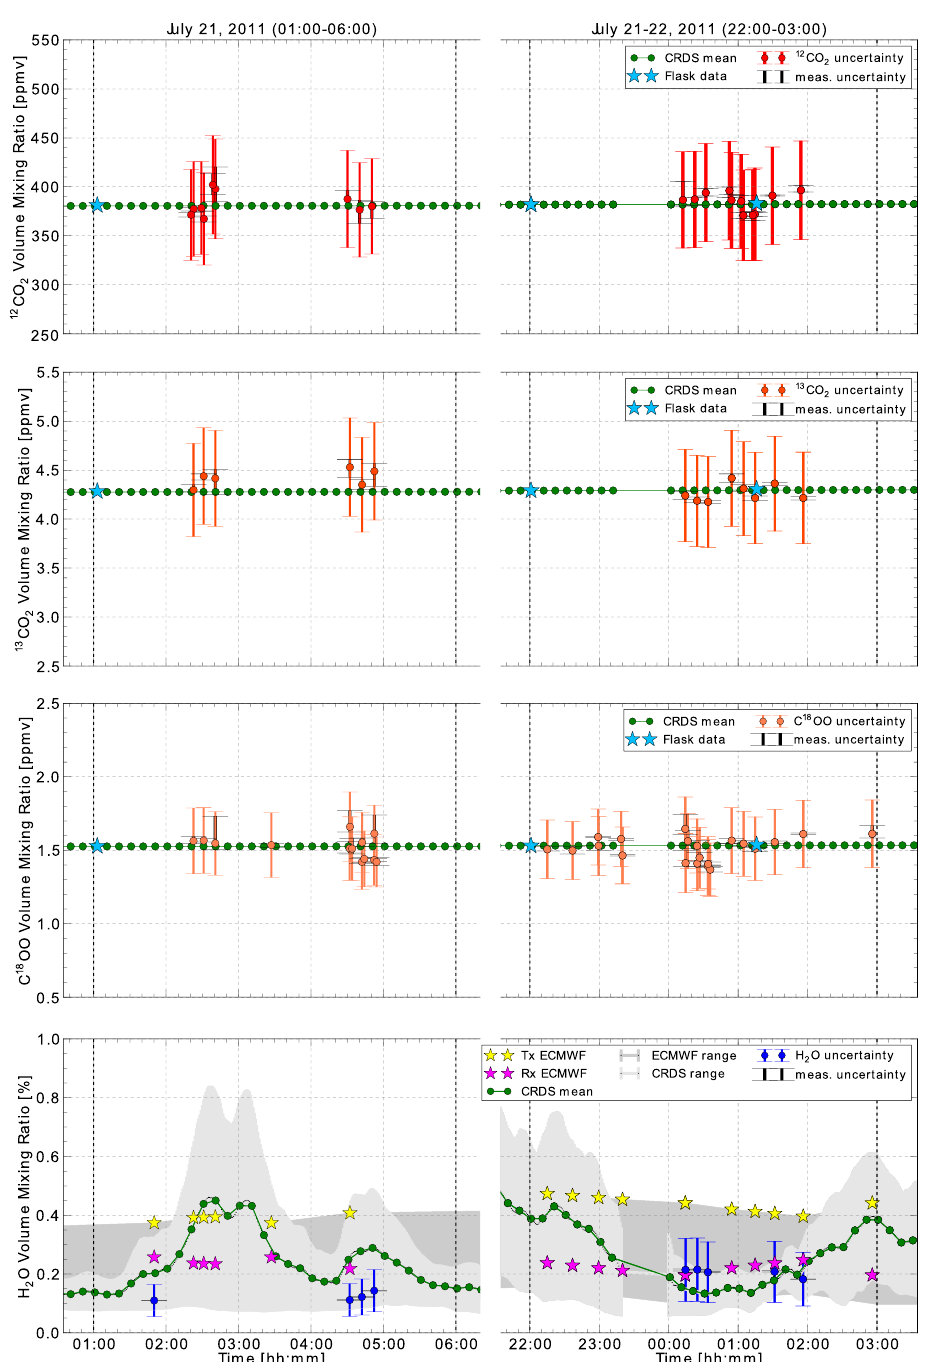
Figure 8. Retrieval results for 12 CO 2 (top panel), 13 CO 2 (upper-middle panel), C 18 OO (lower-middle panel), and H 2 O (bottom panel) volume mixing ratios for the ∼ 10min periods of all available species data from the two successful campaign nights of 21 July 2011 (within 01:00 to 06:00UTC) and 21–22 July 2011 (within 22:00 to 03:00UTC). For each available ∼ 10min period of a retrieved species, the average value (median; red/blue-filled circle), the estimated combined uncertainty (red/blue “error bar”), and the statistical uncertainty of the average (black error bar, generally overlapped by the red/blue error bar and of much smaller range) are shown. For validation reference, the 10min averaged CRDS reference data (green-filled circles), the flask CO 2 data (blue-colored stars in upper three panels), and the Tx/Rx-co-located ECMWF H 2 O data (yellow/magenta-colored stars in bottom panel) are shown. For H 2 O (bottom panel), also the uncertainty ranges of the CRDS data (light gray-shaded area) and ECMWF data (gray-shaded area) are